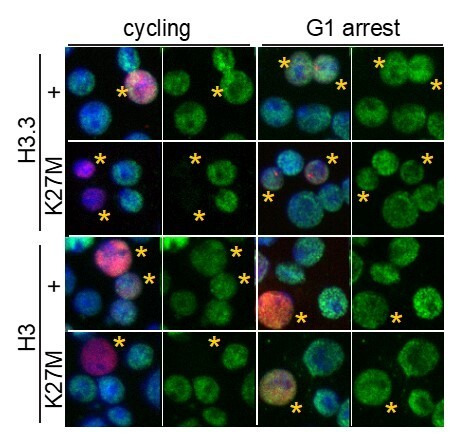
H3K27M fails to inhibit H3K27 trimethylation in G1-arrested cells.S2 cells were lipofected with heat-shock-inducible epitope-tagged histone (red) constructs and allowed to progress through cell cycles or arrested with mimosine for 24 hrs before construct induction or 1 hr at 37°, and then allowed to recover for 8 hrs at 25°. Cells were fixed and stained with anti-H3K27me3 antibody (green) and DAPI (blue). Nuclei with epitope-tagged histone are marked with a yellow asterisks. H3K27M and H3.3K27M oncohistones inhibit H3K27 trimethylation in cycling cells, but are less inhibitory in mimosine-arrested cells.